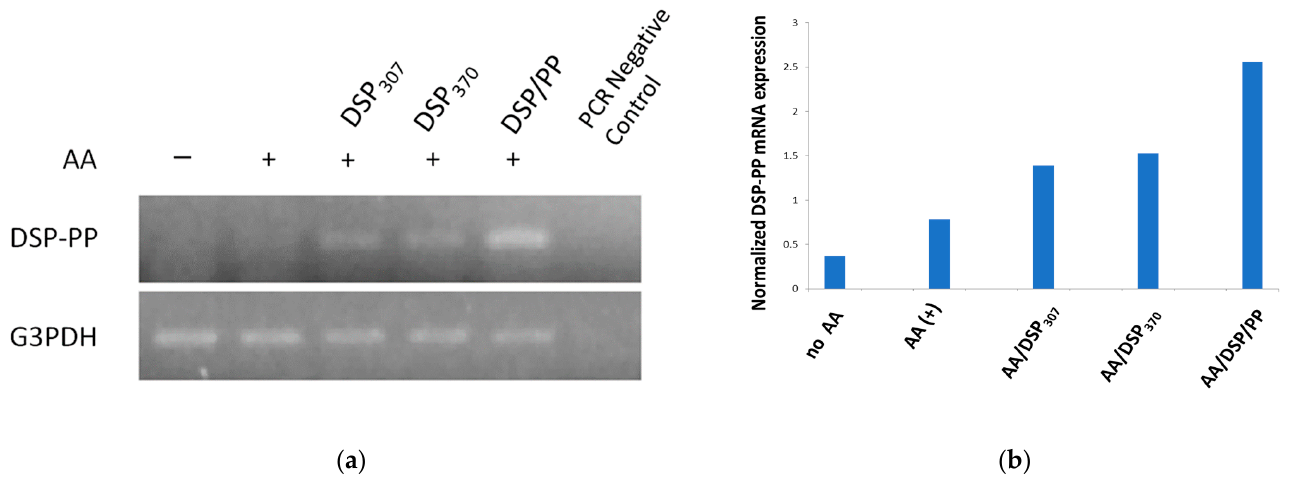
Figure 4. Effect of AA, DSP, and DSP/PP on promoting DSP-PP mRNA expression in M2H4 cells. ( a ) Representative agarose gel electrophoretic patterns of PCR product. ( b ) Normalized mRNA expression levels of M2H4 cells under different treatments.